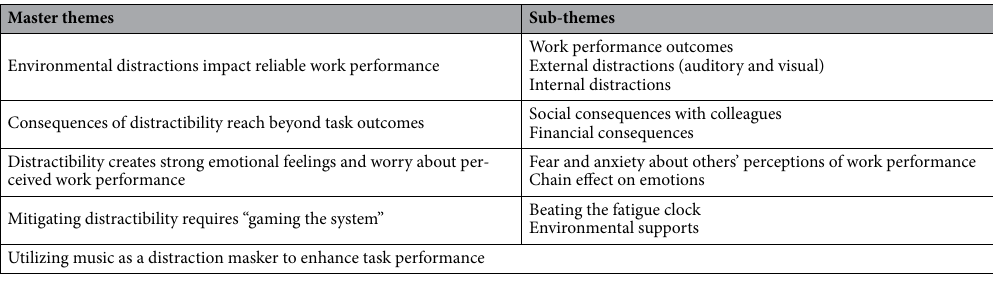
Table 2. Master themes and